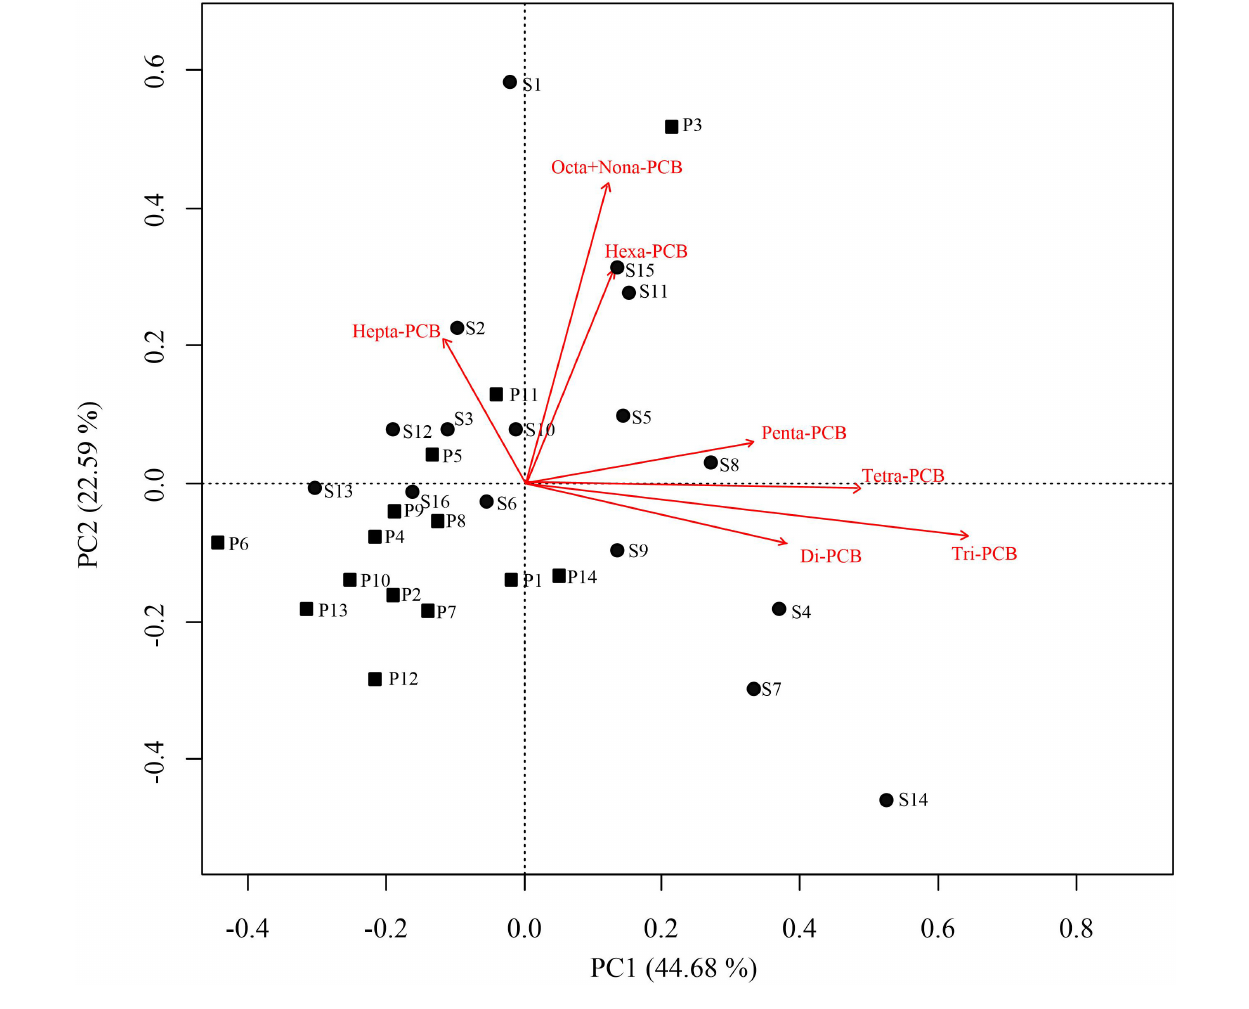
FIGURE 6 | PCA of PCB compositions in the surface sediments of Qingduizi